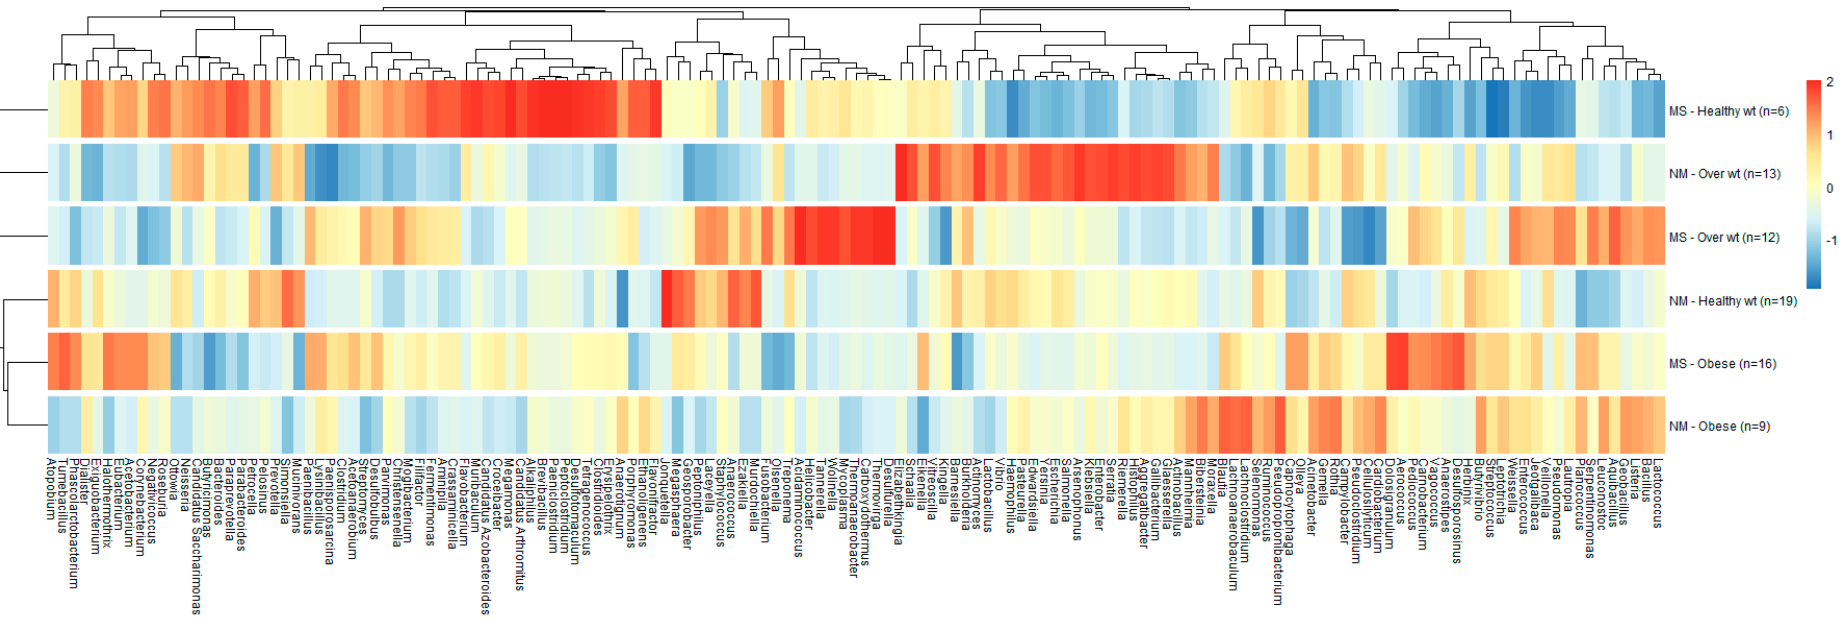
Figure 7. Heatmap showing the distribution of different genera (relative abundance > 0.01%) grouped by BMI and periodontal condition. Relative abundances of genera were ranked based on group counts (scaled across columns). The number of participants in each group is also shown. Red indicates high abundance in a particular group and blue indicates low abundance. Dendrograms show clustering based on the relative abundance of different genera (left dendrogram: group clustering; top dendrogram: clustering of genera based on abundances in different groups).